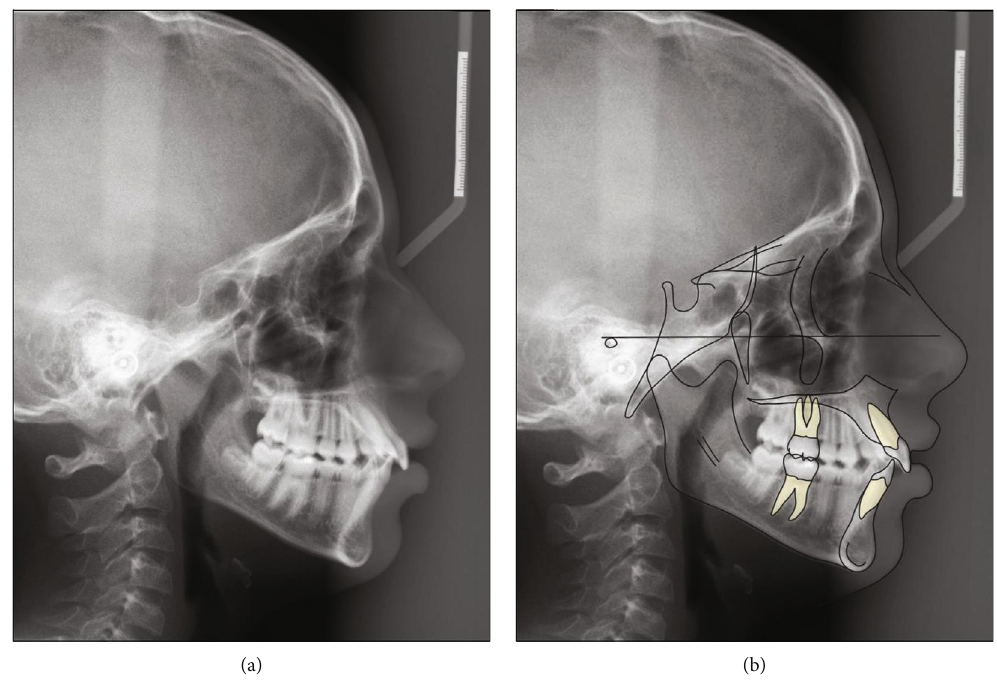
Figure 2: (a) Cephalometric radiograph (b) and cephalometric tracing before